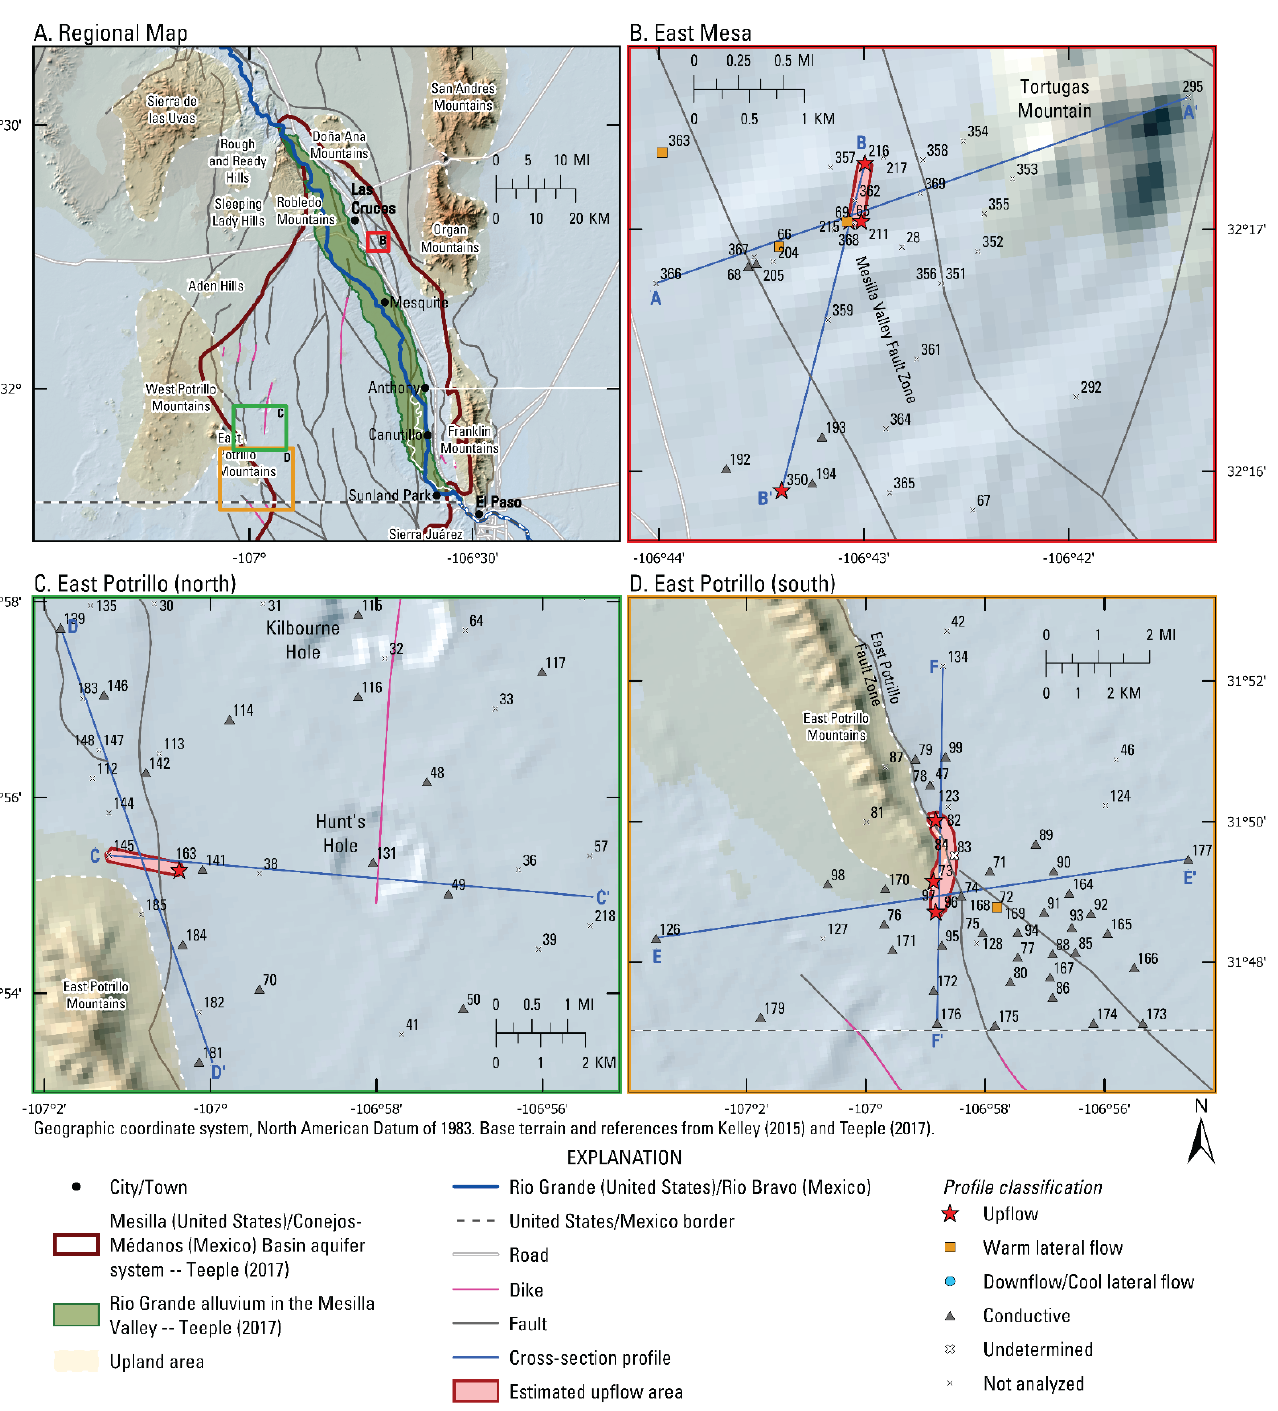
Figure 4. Areal estimates of upflow and relation of faults and dikes to profile classifications for the East Mesa ( B ), East Potrillo (north) ( C ) and East Portrillo (south) ( D ) upflow zones [21,22]. Extents of the insets are given on the regional map inset ( A ). Faults and dikes are from Sweetkind (2017) [27]. Profile locations are labeled with their profile ID number from Pepin et al. (2019) [18].